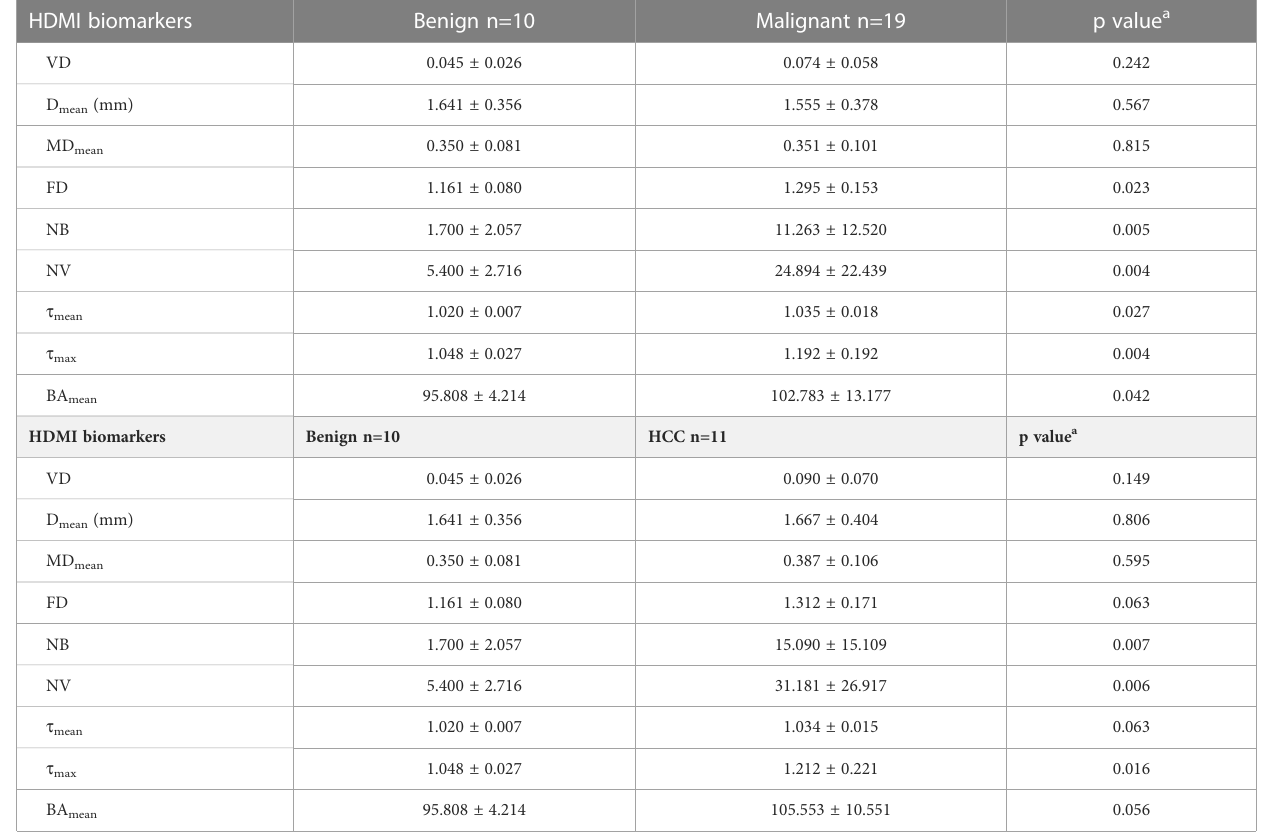
TABLE 2 Associations of HDMI biomarkers for benign vs . malignant and benign vs .